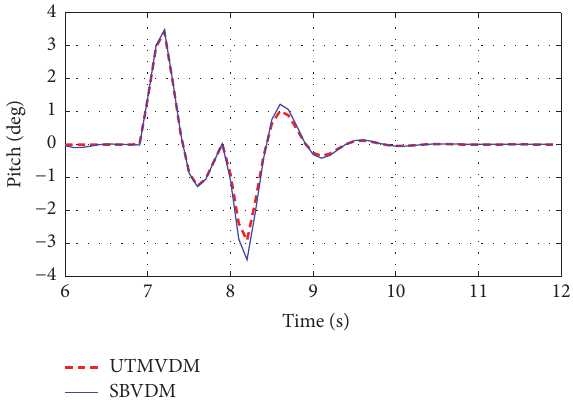
Figure 20: Vehicle pitch angle when passing a